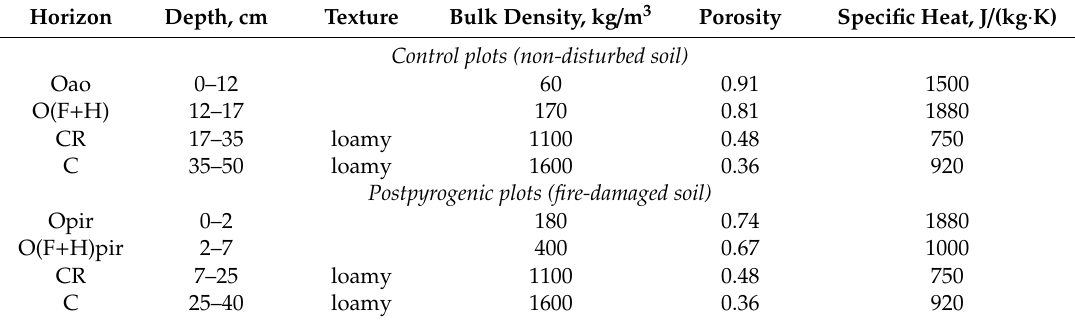
Table 1. Permafrost soil layer characteristics, summarized from